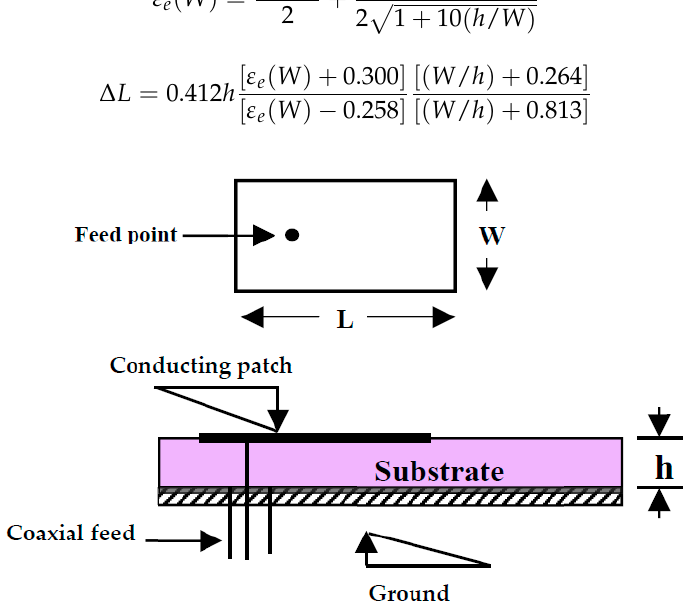
Figure 1. Geometry of rectangular MSA.